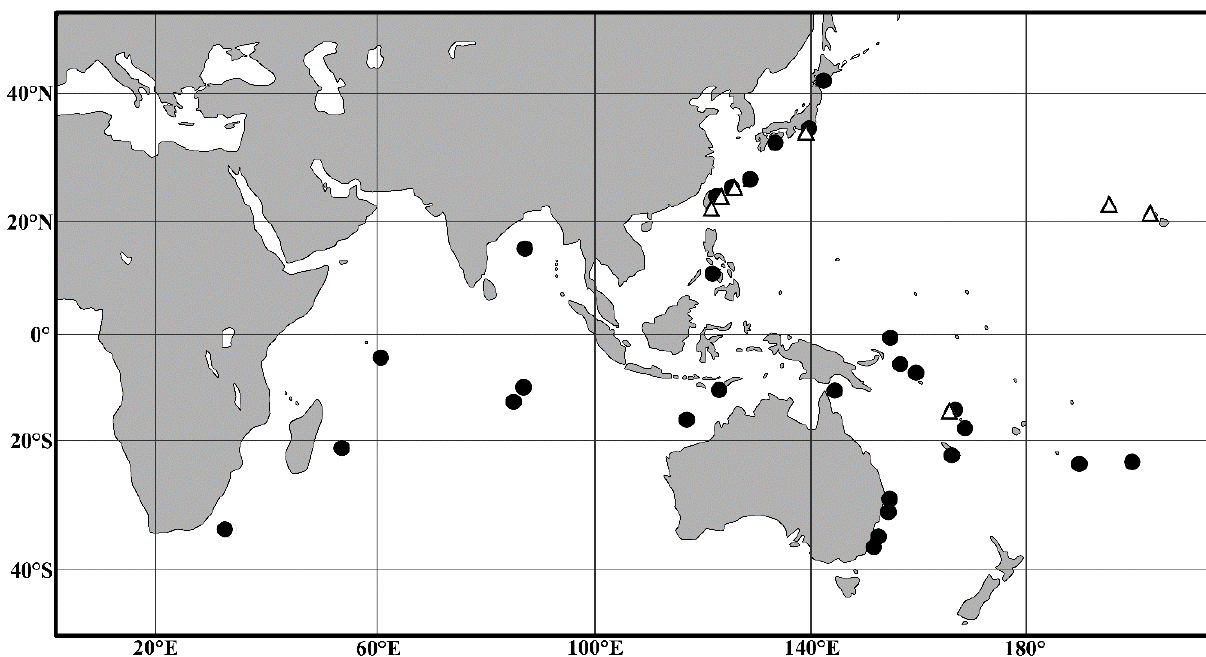
Figure 17. Distribution map of H. margaretea (open triangles) and H. nudiventer (black dots). One dot may represent more than one capture.